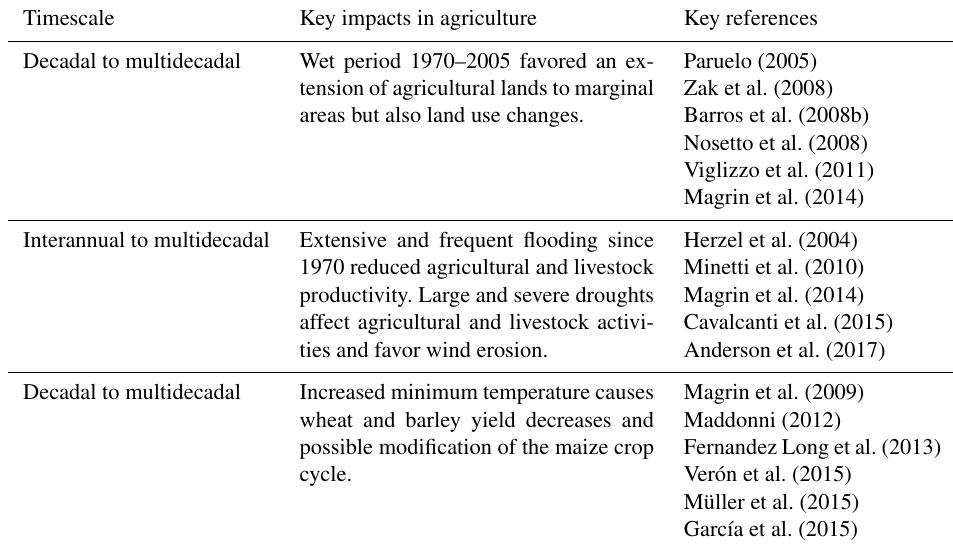
Table 4. Impacts of hydroclimate variability and its extremes in agriculture. The first column shows the main timescale of variability affecting the study sector. Key impacts in